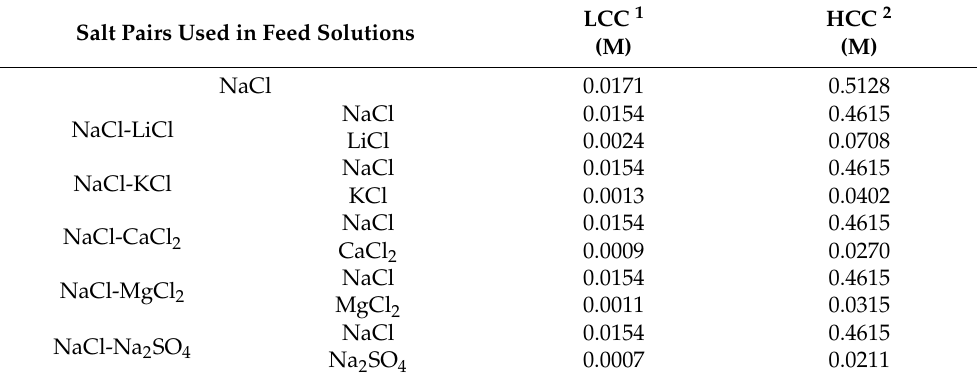
Table 4. Quantities of salt used in feed solutions.